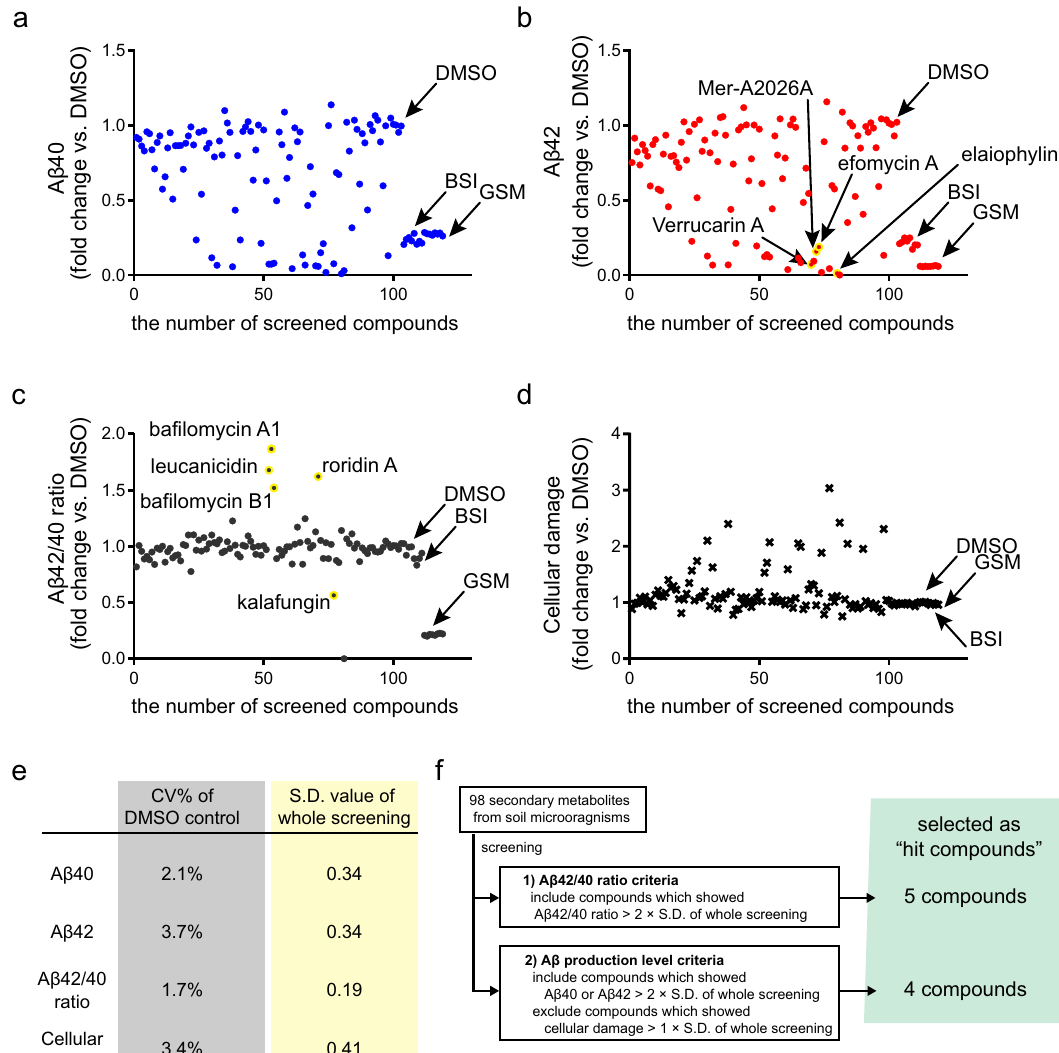
Figure 2. Primary screen results by using cortical neurons of sporadic Alzheimer’s disease. Scatter plot graph of ( a ) Aβ40 (blue round), ( b ) Aβ42 (red round), ( c ) Aβ42/40 ratio (black round), and ( d ) cellular damage (black x-mark). Fold change compared with DMSO control was plotted after adding compounds at a concentration of 1 μM. Hit compounds were highlighted by yellow color with compound name. DMSO dimethyl sulfoxide (negative control), BSI β-secretase inhibitor (β-secretase inhibitor IV, positive control for Aβ40), GSM γ-secretase modulator (JNJ-40418677, positive control for Aβ42 and Aβ42/40 ratio). ( e ) Table showing coefficients of variation (CV%) of DMSO, negative control (left column), and standard deviation (S.D.) of whole screening for each analyte. ( f ) Hit selection